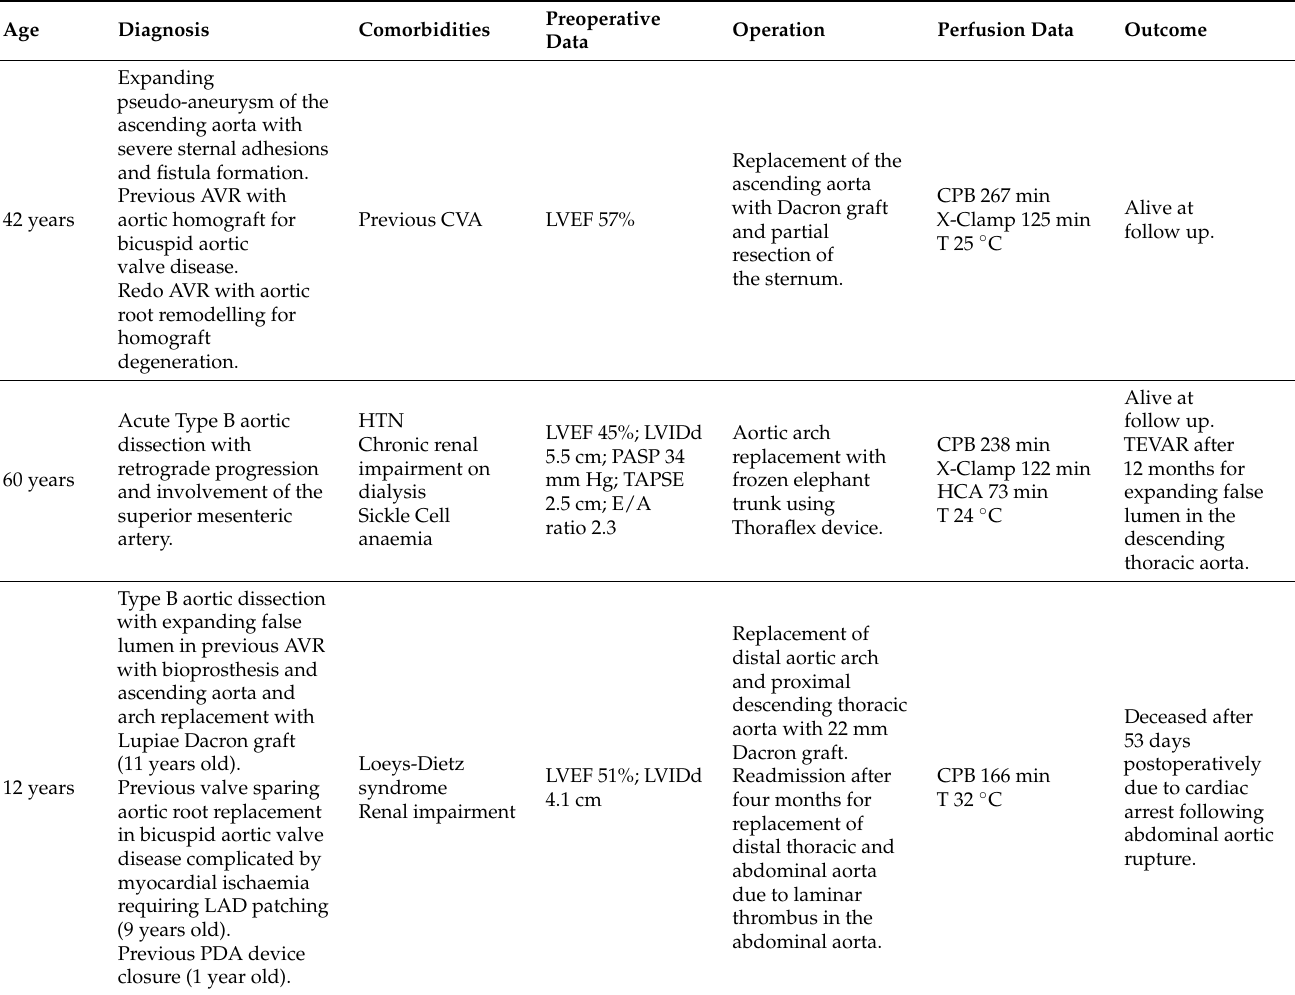
Table 1. Clinical and operative data: LVEF (left ventricular ejection fraction); LVIDd (left ventricular internal diastolic diameter); PASP (pulmonary artery systolic pressure); TAPSE (tricuspid annular plane systolic excursion); HTN (hy- pertension); DM (diabetes mellitus); CVA (cerebro-vascular accident); LAD (left anterior descending coronary artery); CPB (cardio-pulmonary bypass); X-Clamp (aortic cross-clamp); HCA (hypothermic circulatory arrest); AVR (aortic valve replacement); CoA (aortic